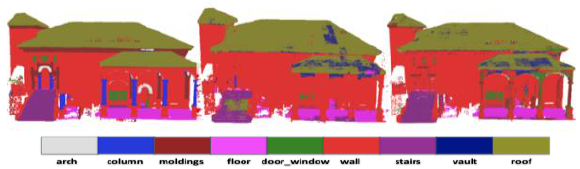
Figure 8. Qualitative outcomes for semantic segmentation of “B SMV chapel 27to35” while training with all scenes from the ArCH Dataset. The picture in each column represents the same meaning as each column of Figure